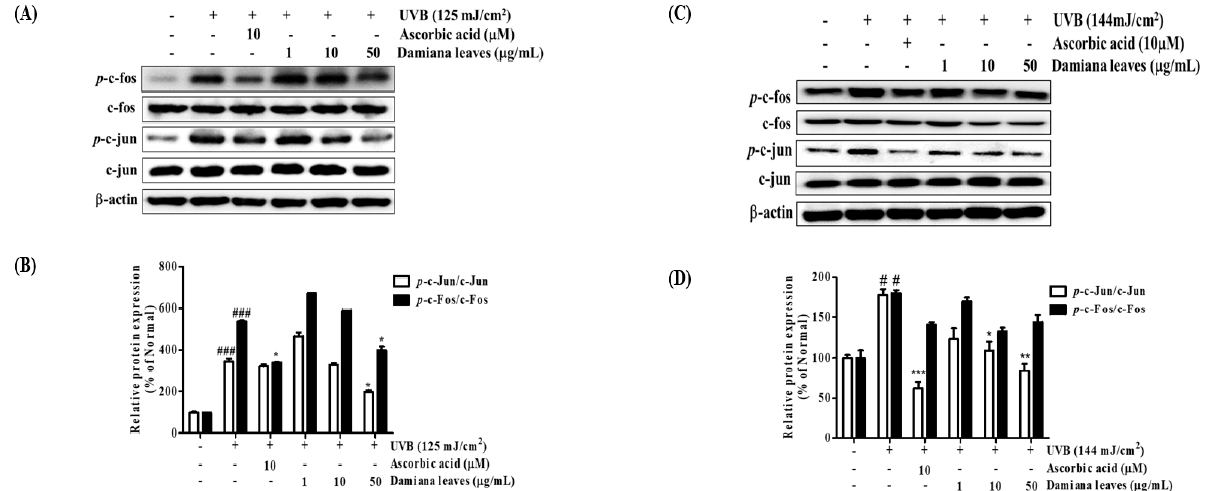
Figure 10. Effect of Damiana leaves extract on protein expression of phosphorylated c-fos and c-jun signaling pathway on UVB-irradiated HaCaT ( A , B ) and HDF ( C , D ) cells. Data are presented as the mean ± SD. # and * indicate significant differences from the non-irradiated control and UVB-treated groups, respectively. # and ### p < 0.05 and 0.001 vs. the non-treated group, respectively. *, ** and *** p < 0.05, 0.01, and 0.001 vs. the UVB-treated control, respectively.